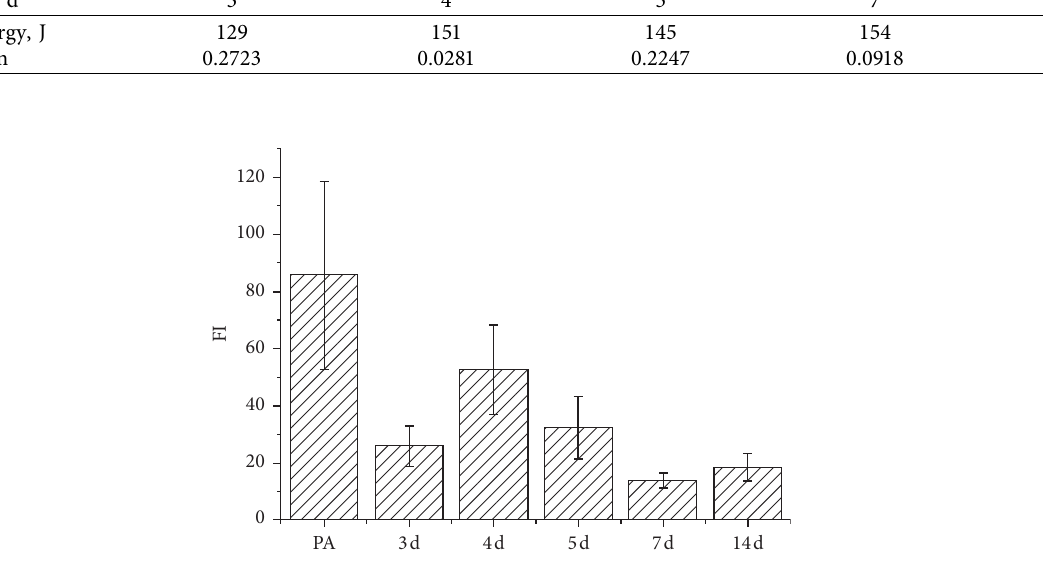
Figure 12: FI of PA and SFP specimen with different curing